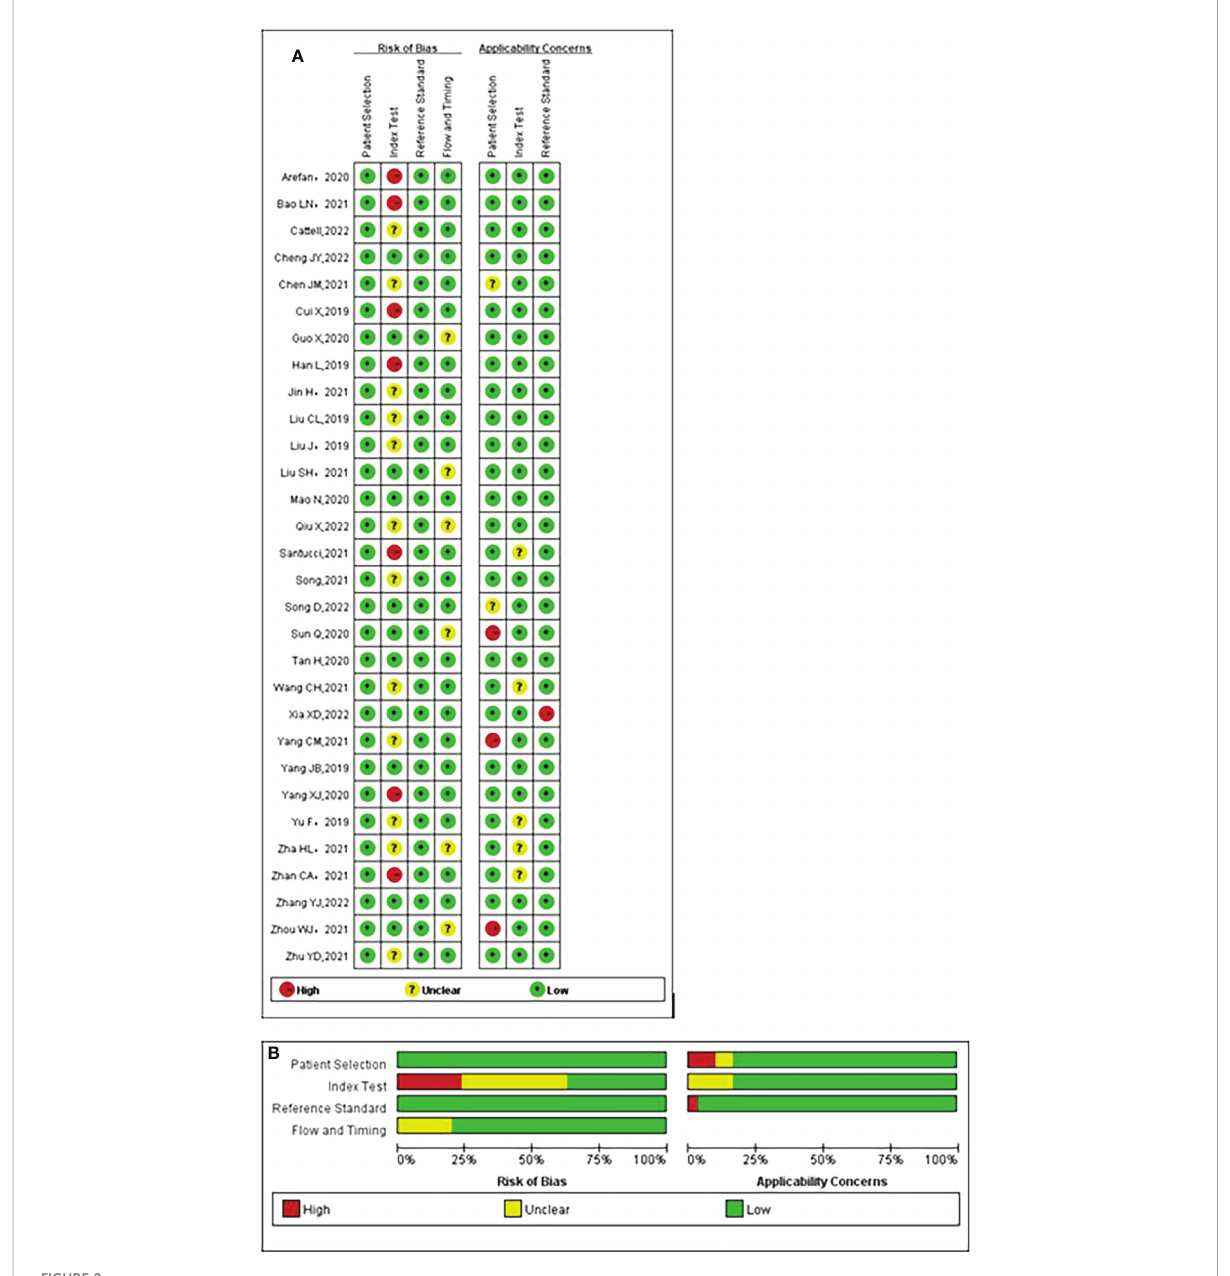
FIGURE 2 Quality assessment of included studies according to Quality Assessment of Diagnostic Accuracy Studies-2 (QUADAS-2) criteria. (A) Individual studies, (B) summary. Green, yellow, and red circles denote low, unclear, and high bias risks,